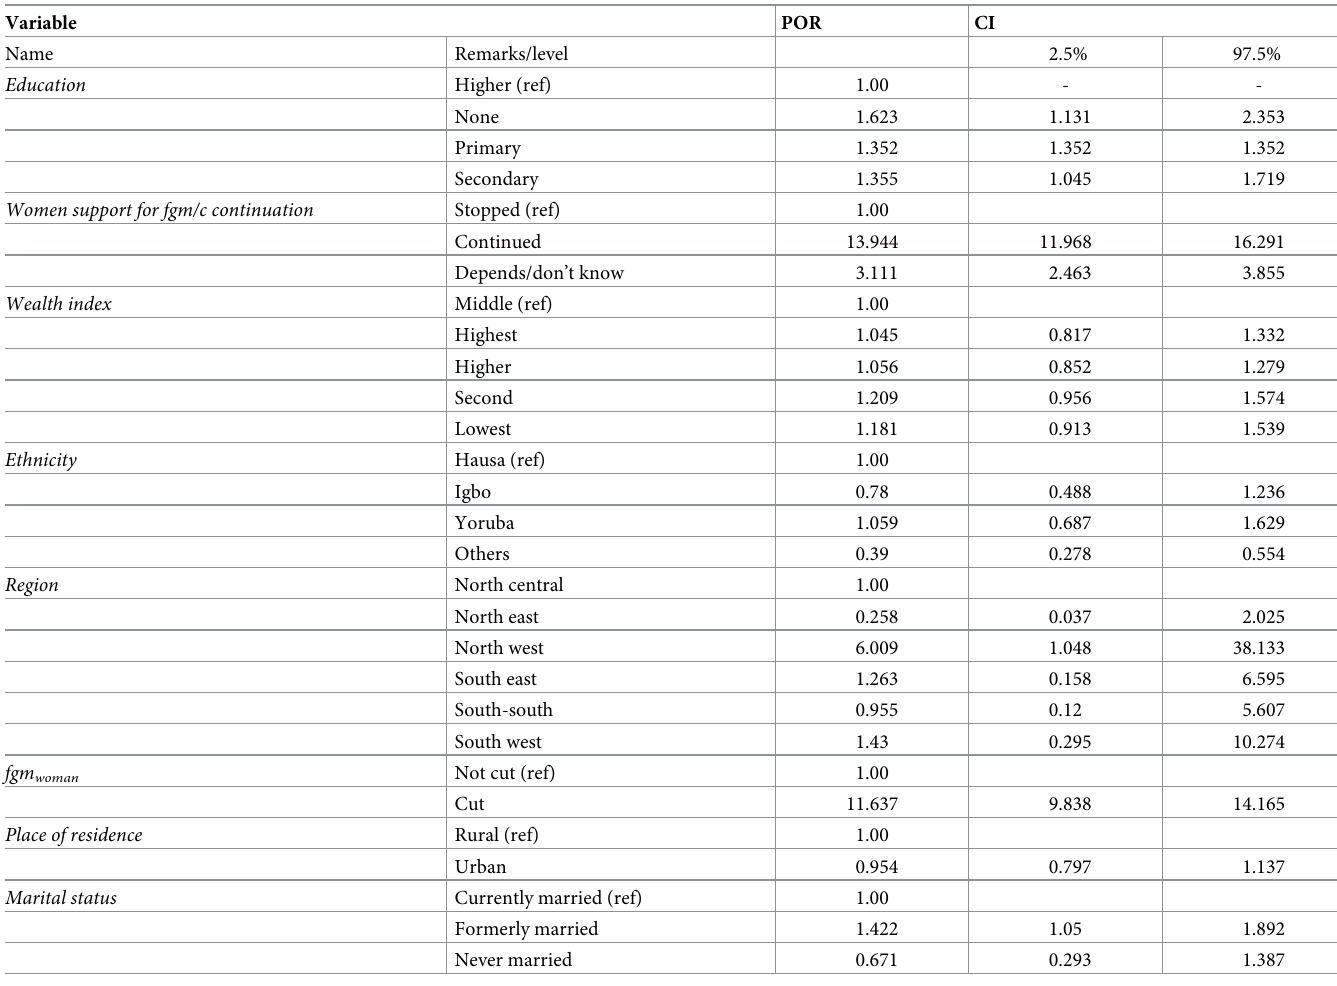
Table 4. Posterior odds ratio estimates from the Bayesian geo-additive regression model (adjusted) fitted to the 2016 MICS